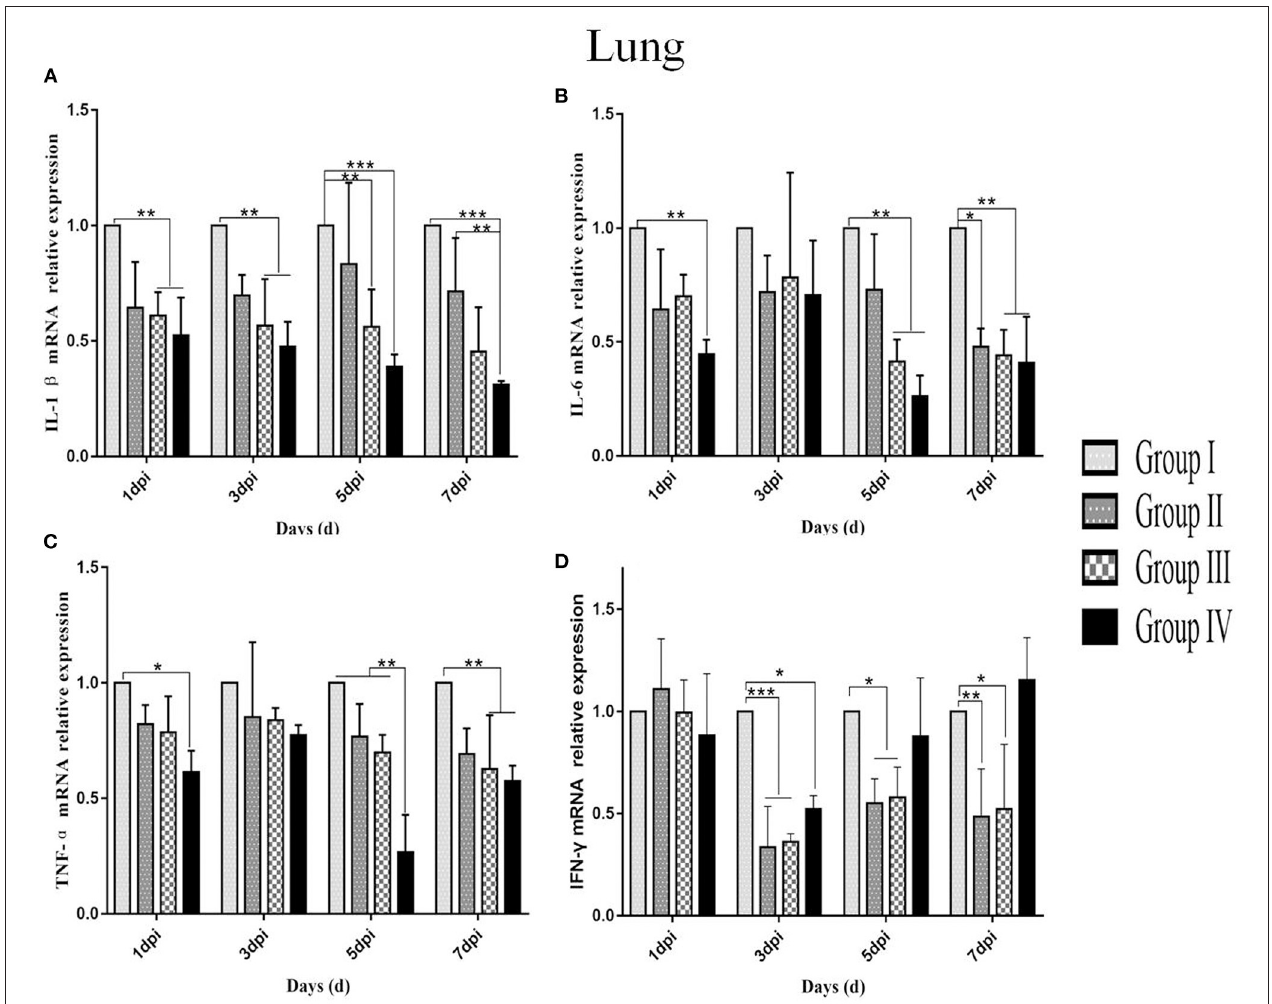
FIGURE 8 | Relative mRNA expressions of IL-1 β , IL-6, TNF- α , and IFN- γ in the lungs at 1, 3, 5, and 7 dpi. (A – D) Represent IL-1 β , IL-6, TNF- α , and IFN- γ mRNA relative expressions in the lung, respectively. Group I served as a control. Broilers in Group II were given doxycycline whereas those in Group III were given SGDL granule through drinking water. Broilers in Group IV were given SGDL granule and doxycycline in drinking water. It was intraocularly and intranasally challenged by IBV at day 28. Extremely significant ( p < 0.005) different values are shown with ***, extremely significant ( p < 0.01) different values are shown with **, significantly ( p < 0.05) different values are shown with *, and no signal was not significantly ( p > 0.05) different between the groups at those time points. SGDL,